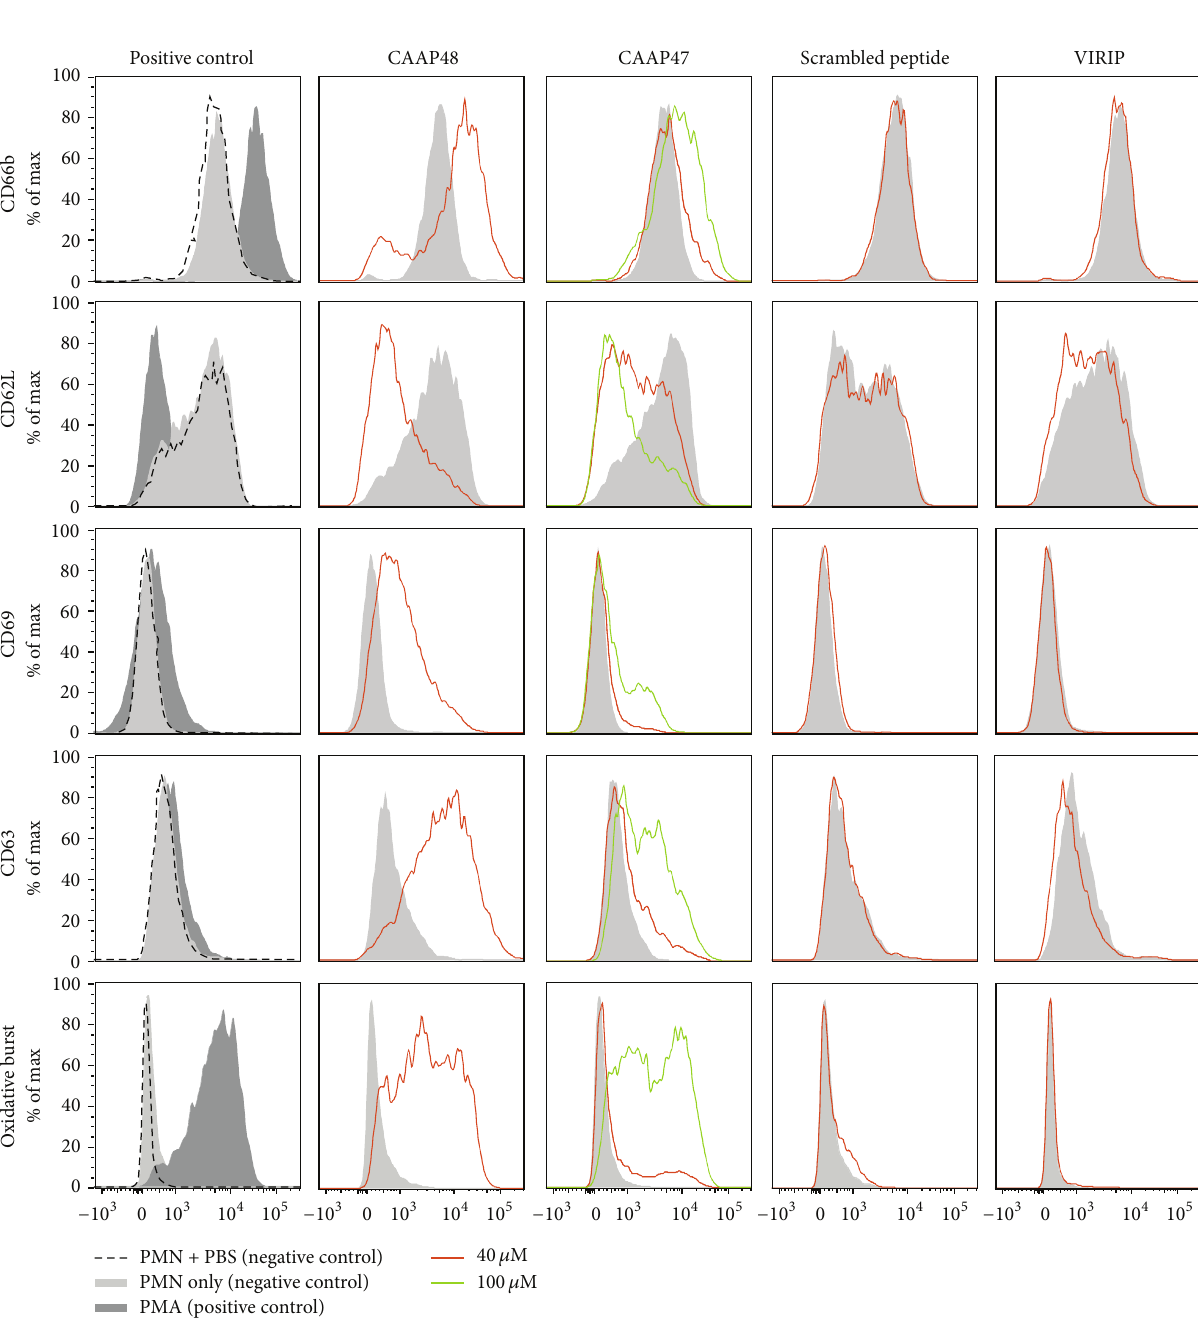
for two independent samples was applied for determination of statistical significance. Cutoff values from ROC-curves were determined using the Youden index [31]. Determina- tion of significant differences between the areas under two